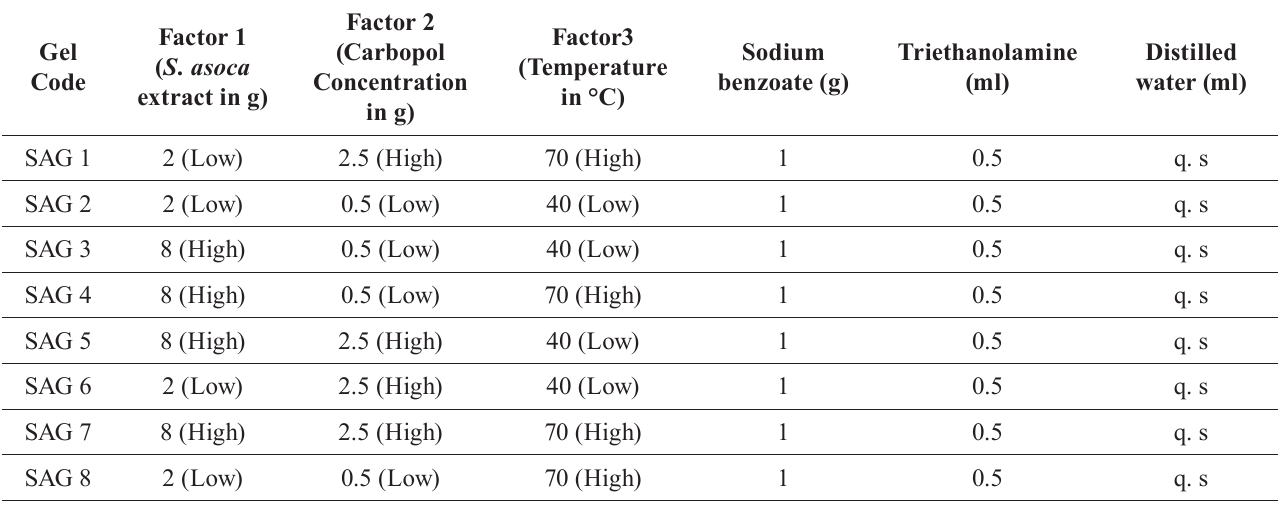
TABLE I - 2 3 full factorial design matrix showing composition of different batches of SAG